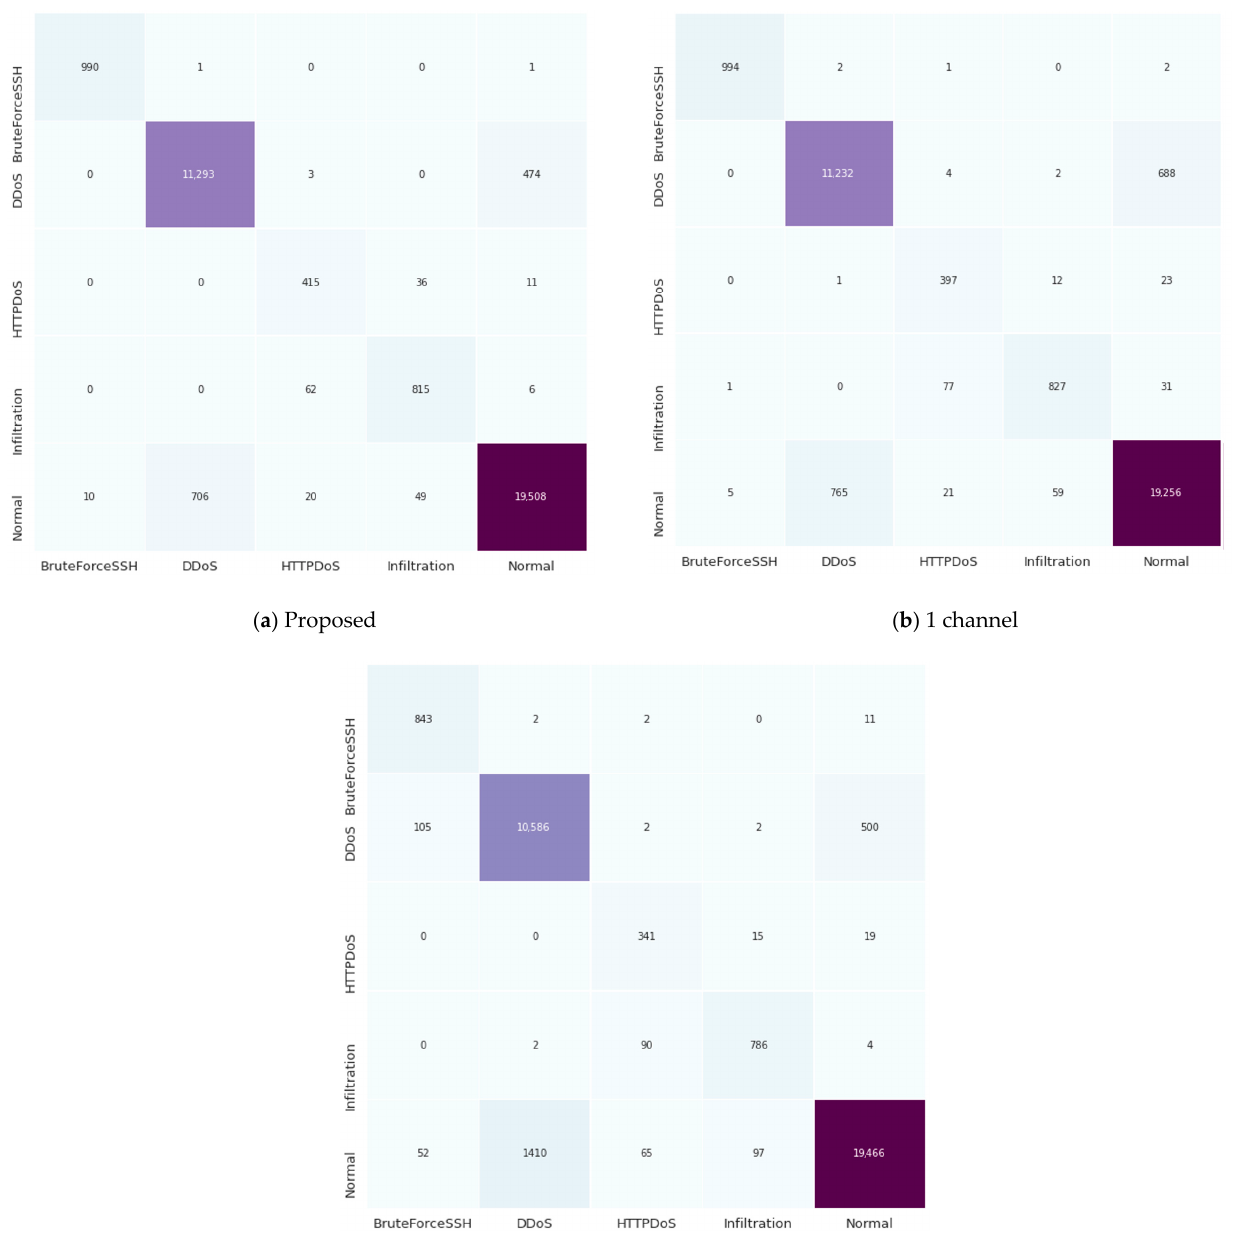
Figure 7. ISCIDS2012 Confusion matrix. Each row shows predicted result for each class.